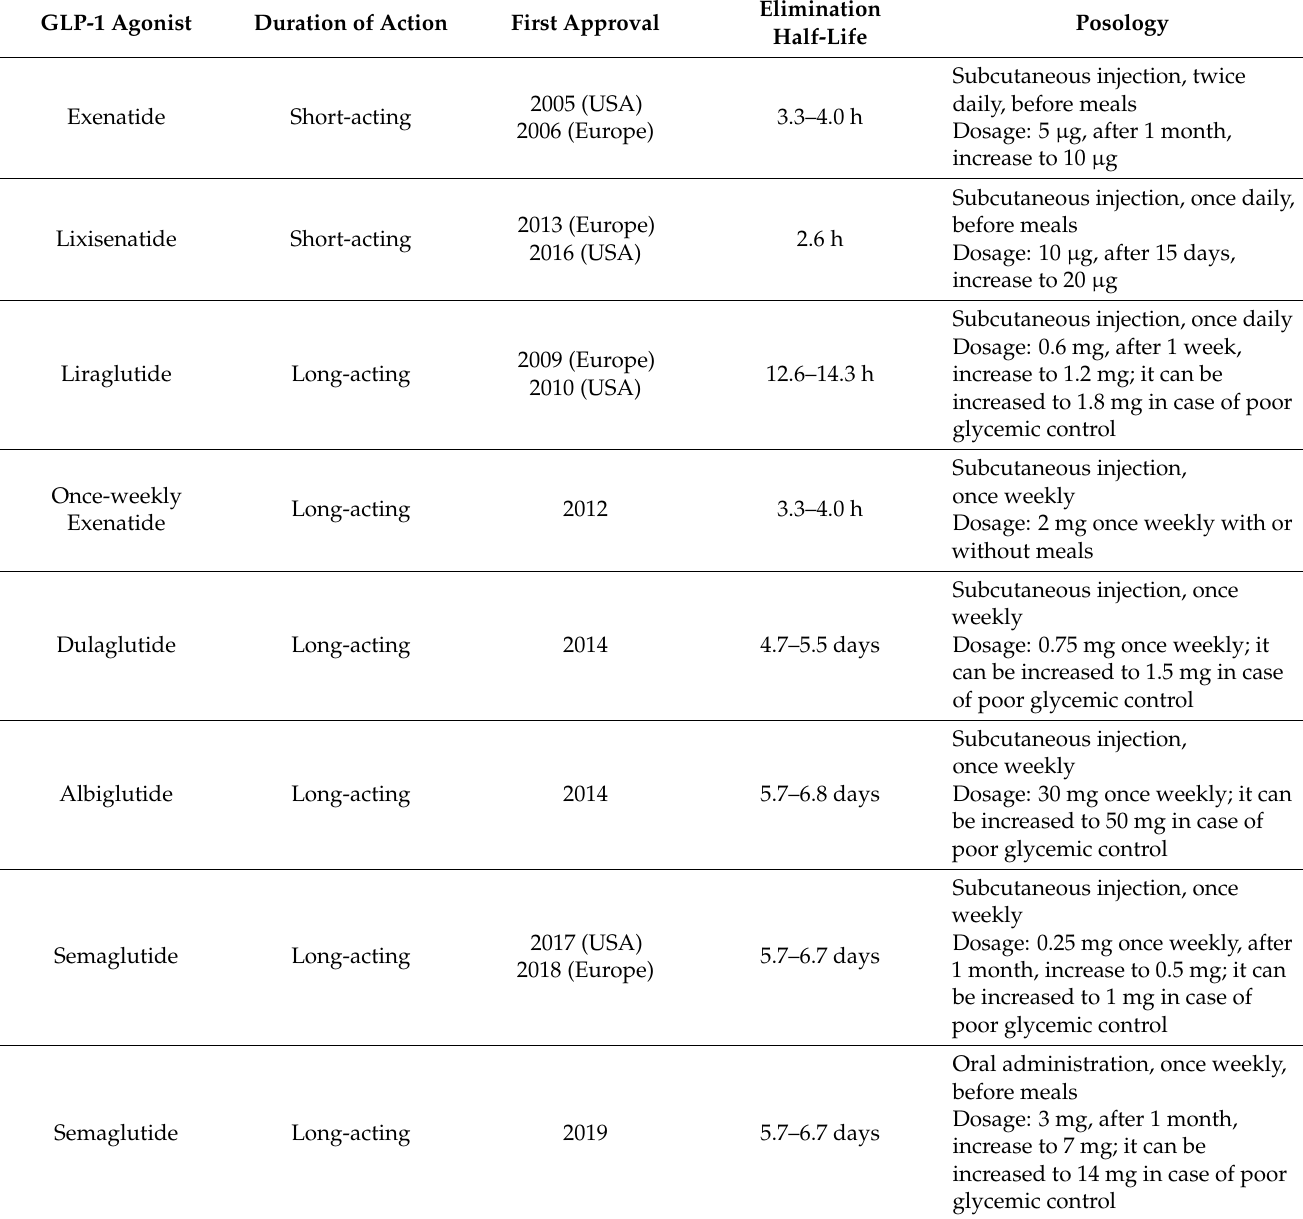
Table 2. GLP-1 RAs approved for T2DM